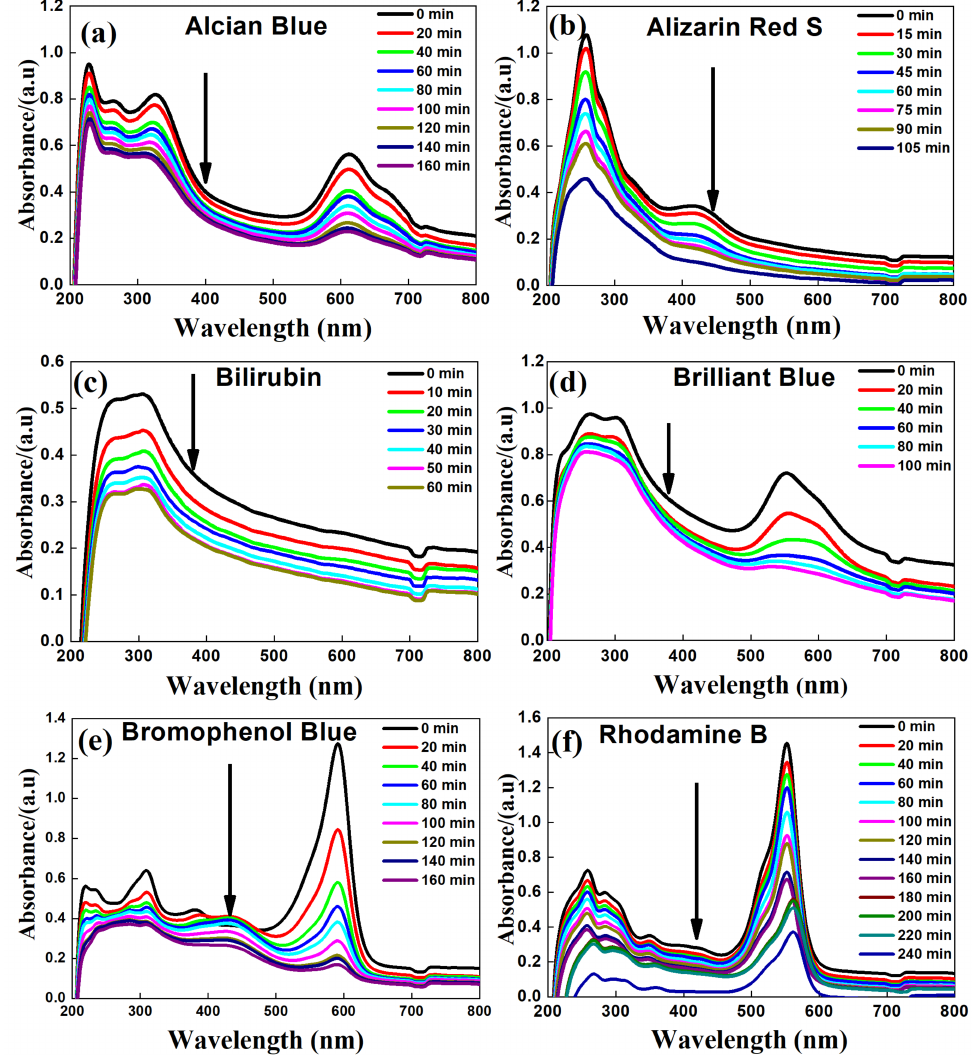
Figure 5. Degradation and decolorization of different dyes with composite TiO 2 -SnO 2 nanofiber catalyst ( a ) Alcian Blue; ( b ) Alizarin Red S; ( c ) Bilirubin; ( d ) Brilliant Blue; ( e ) Bromophenol Blue; and ( f ) Rhodamine